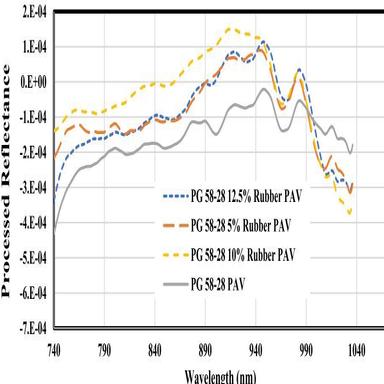
Comparison of the PG 58-28 PAV binders with different percentages of rubber.